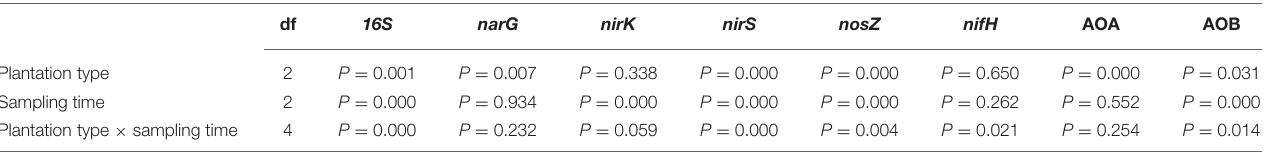
TABLE 3 | P -values obtained from a two-way analysis of variance (ANOVA) to detect the effects of plantation type, sampling time, and their interaction on the abundances of the functional genes involved in soil N cycling at Kolombangara, Solomon Islands.